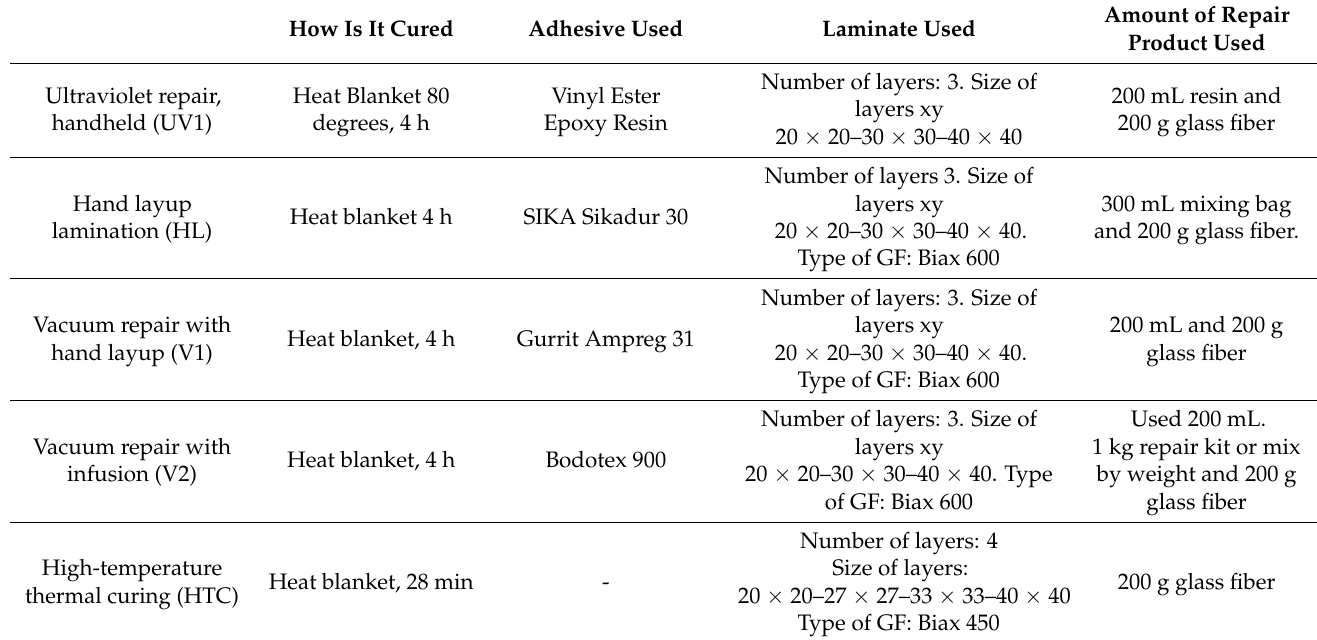
Table 3. Adhesives, laminates, and resins